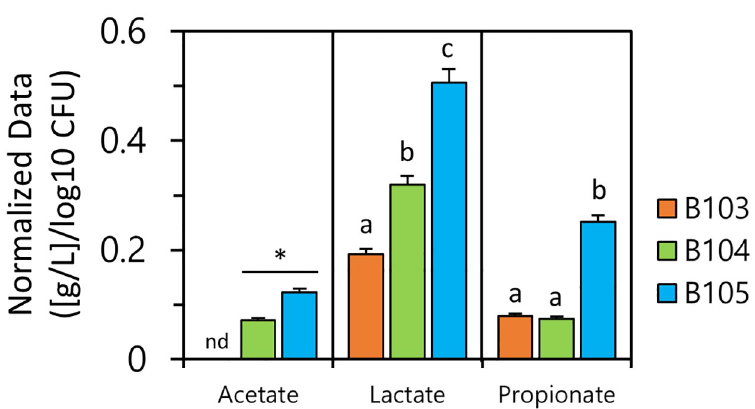
Fig 6. Organic acids production by LAB strains. Values for organic acid are means of data from triplicate experiments each of which contained three technical replicates. For presentation, all data were normalized to cell population (log10 CFU/mL). Columns marked with an asterisk ( * ) indicate statistically significant differences for acetate production between B104 and B105 strains using Student’s t test ( P � 0.05). nd: not detected. One-way ANOVA, Tukey test, P < 0.05 for lactate and propionate of the three LAB strains. Different letters indicate significant differences ( P < 0.05) between LAB strains.